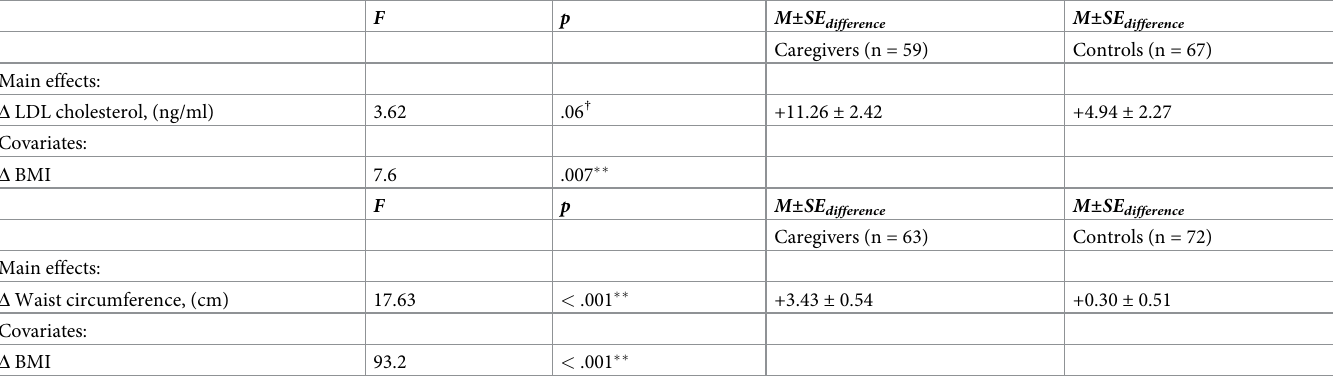
Table 6. One-way ANCOVA for group differences in metabolic health change from baseline to 2 years, adjusting change in BMI from baseline to 2 years.